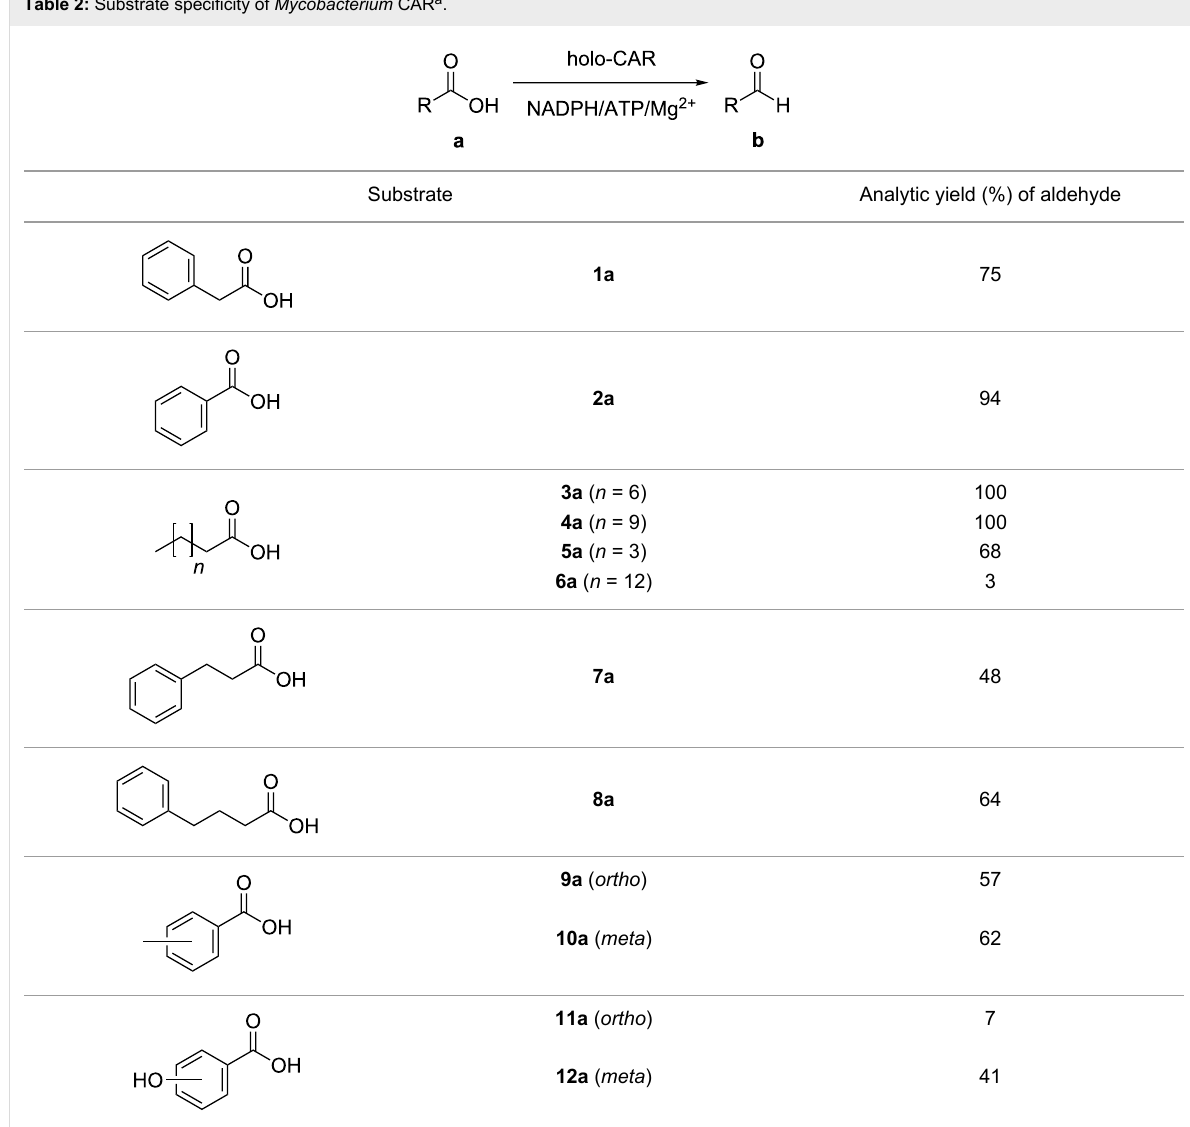
Table 2: Substrate specificity of Mycobacterium CAR a